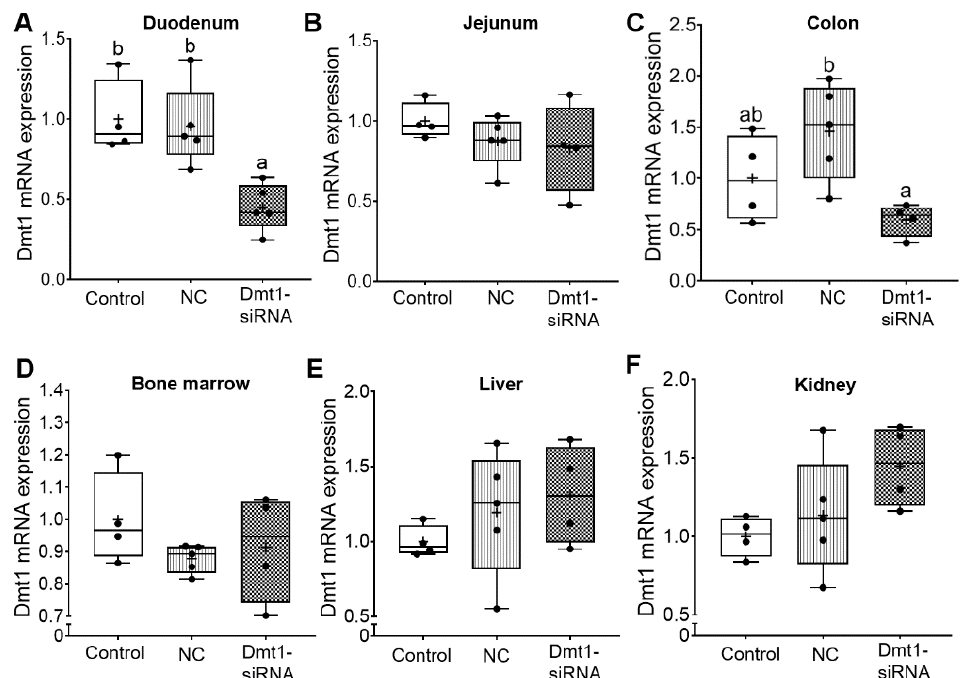
Figure 5. FA-GDLVs loaded with Dmt1 siRNA decreased Dmt1 mRNA expression in duodenum. Female Hamp − / − mice were weaned onto a standard chow diet and then switched to a low-iron diet 1 day before NP treatment. Starting at 5 weeks of age, mice were orally gavaged with saline (control), negative control-siRNA (NC-siRNA) or DMT1-siRNA FA-GDLVs daily for three weeks. Dmt1 mRNA expression was quantified in duodenum ( A ), jejunum ( B ), colon ( C ), bone marrow ( D ), liver ( E ), and kidney ( F ). Expression of experimental genes was normalized to expression of Cyclophilin. Data are presented as box plots for n = 4–5 mice per group. Statistical significance was assessed by one-way ANOVA ( A – F ), followed by a Tukey’s multiple comparisons test ( A , C ). Groups labeled with different letters differ significantly. p = 0.0037 ( A ), p = 0.0239 ( C ). NC, negative control; +, mean value.